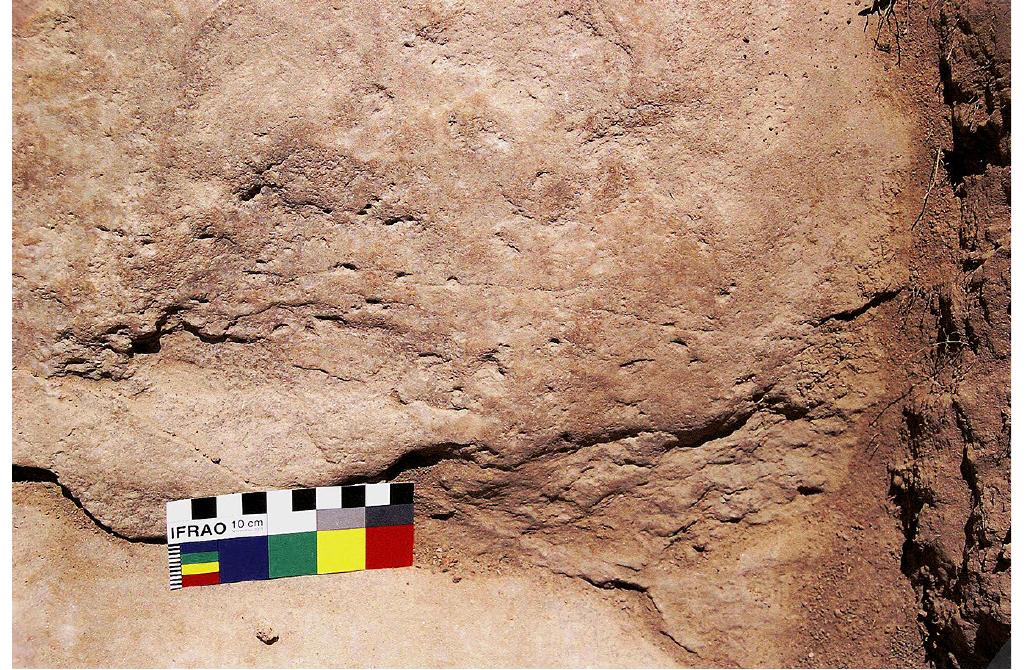
Figure 3. Peck marks at Hensler Petroglyph Site, Dodge County, Wisconsin, shown to be at least 10,000 years old (after Steinbring